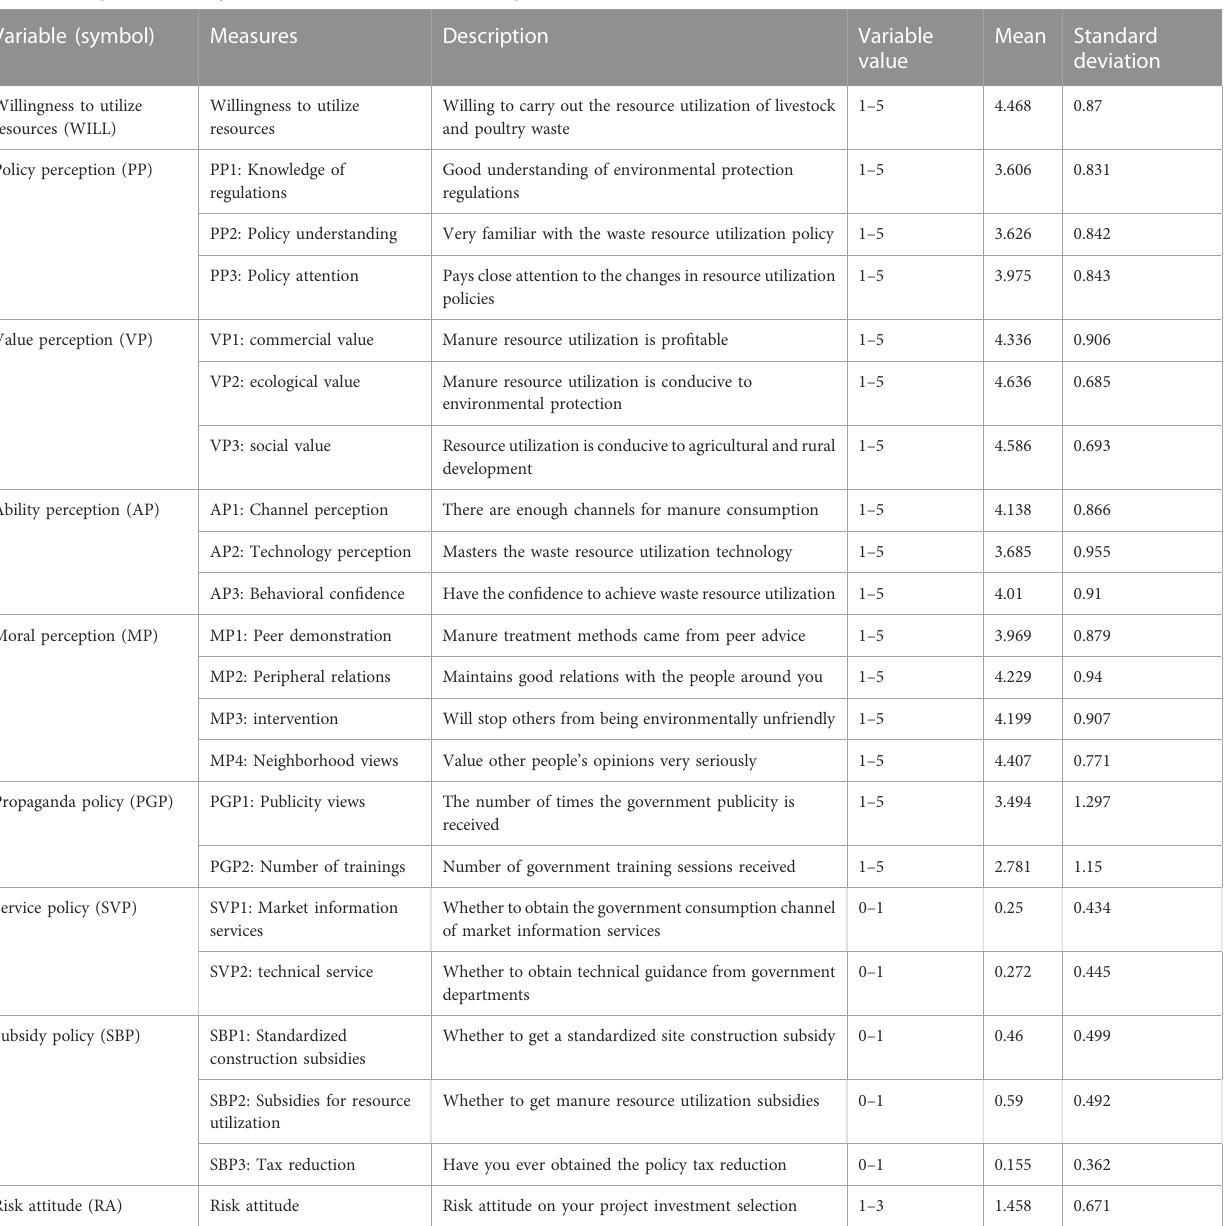
TABLE 2 Description of the key variables and their statistical description. Variable